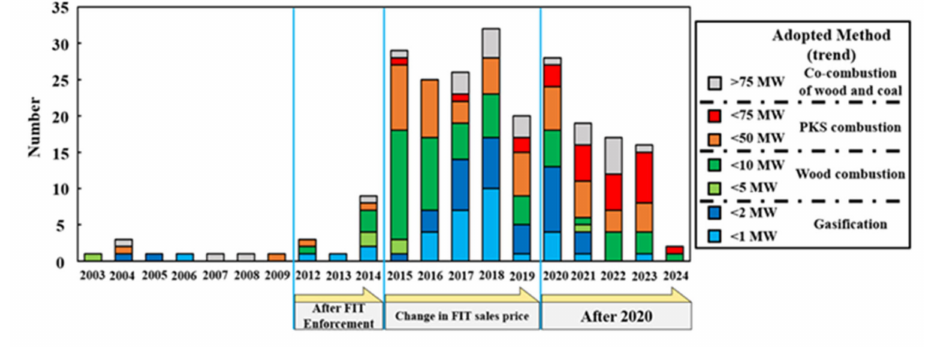
Figure 1. Number of woody biomass power generation projects by scale.